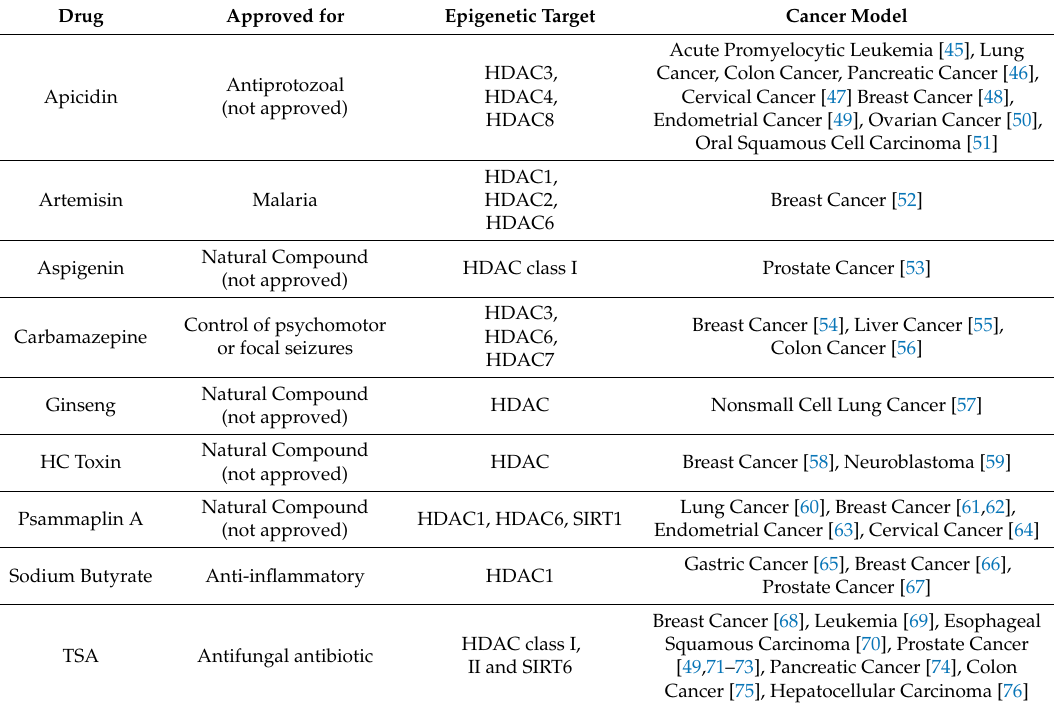
Table 2. Noncancer drug repurposing candidates for HDAC